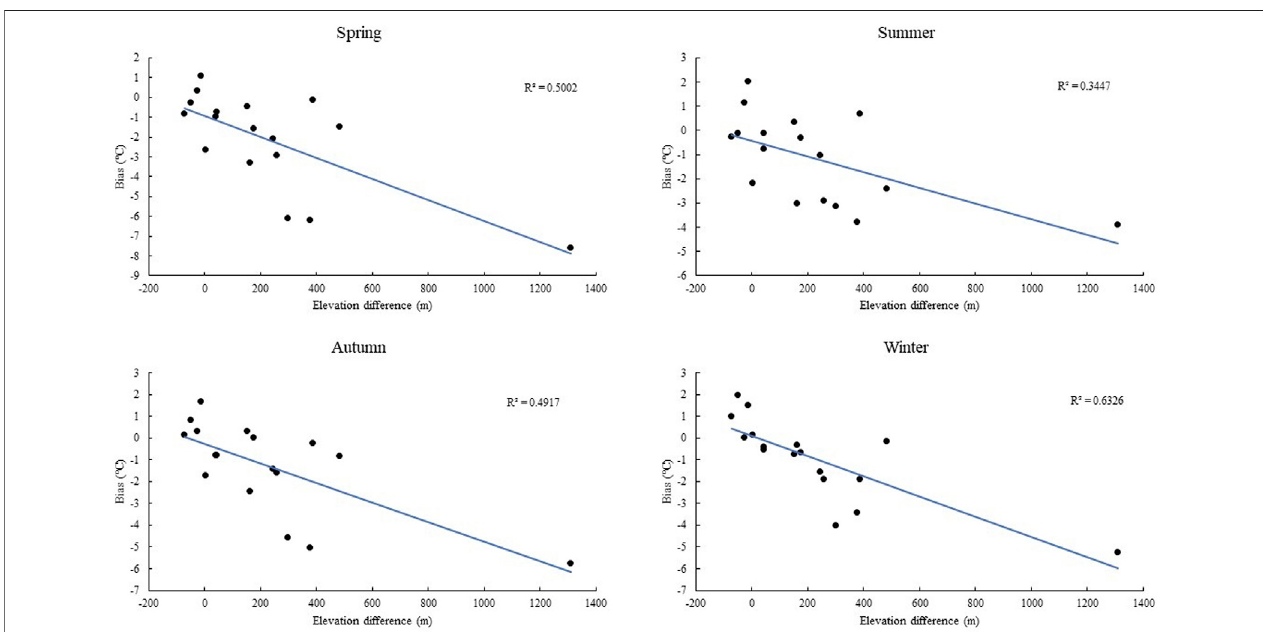
FIGURE 9 | Relationship of bias and elevation differences between seasonal observations and ERA5-Land during the 1979 – 2017 period.